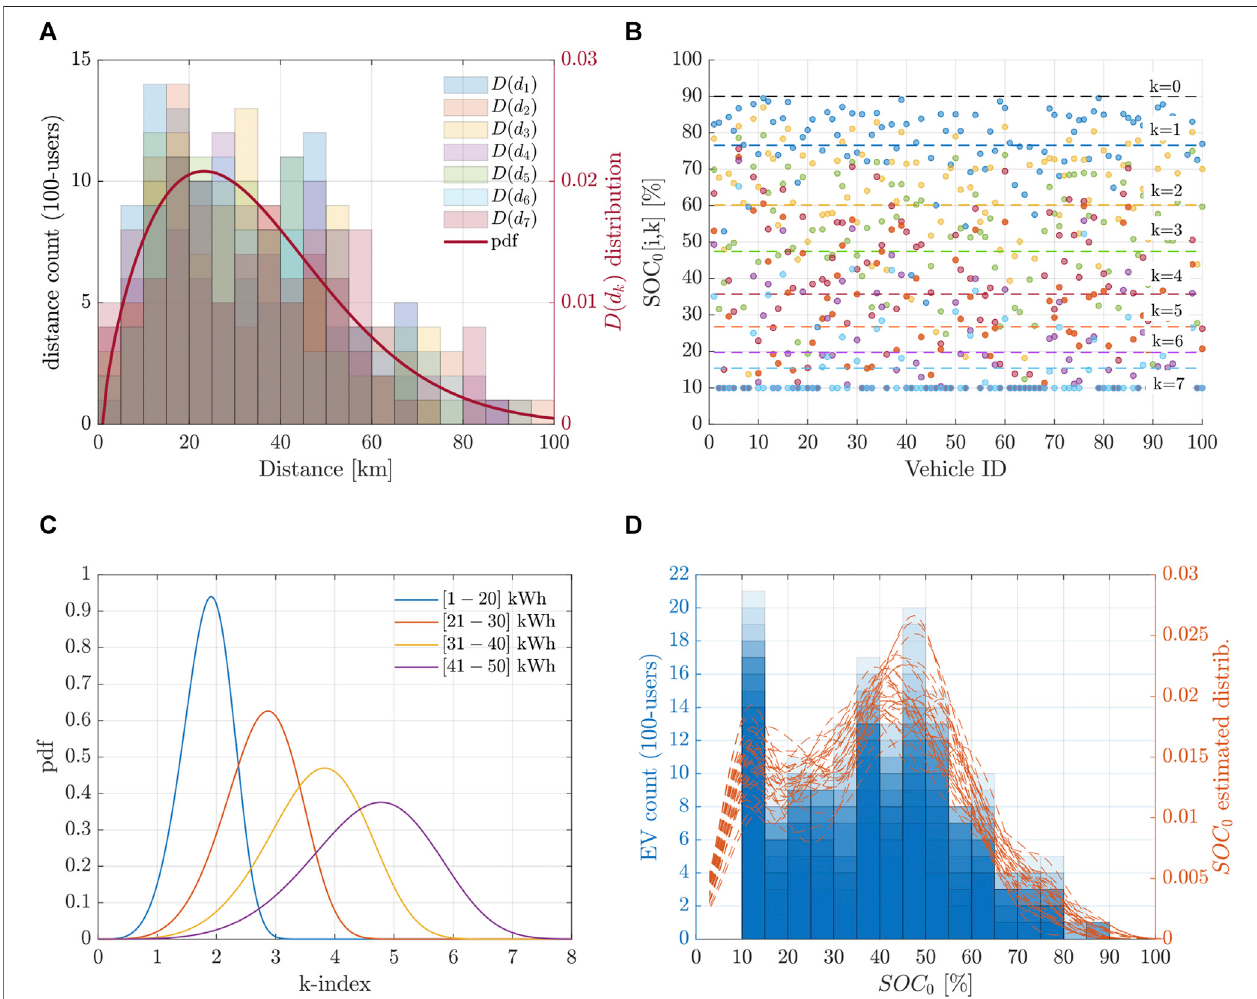
FIGURE 3 | (A) distance D ( d k ) distribution (red trace) of a 100-EV population, estimated on 7 days (colored tiles). (B) SOC 0 [ i , k ] elements distinguished on seven d k (colored clusters) along with their average initial SOC (colored dashed trace). (C) Distribution of the k -index for different capacity diapasons. (D) 31-day SOC 0 distributions (red traces) together with the corresponding histograms (blue bars).